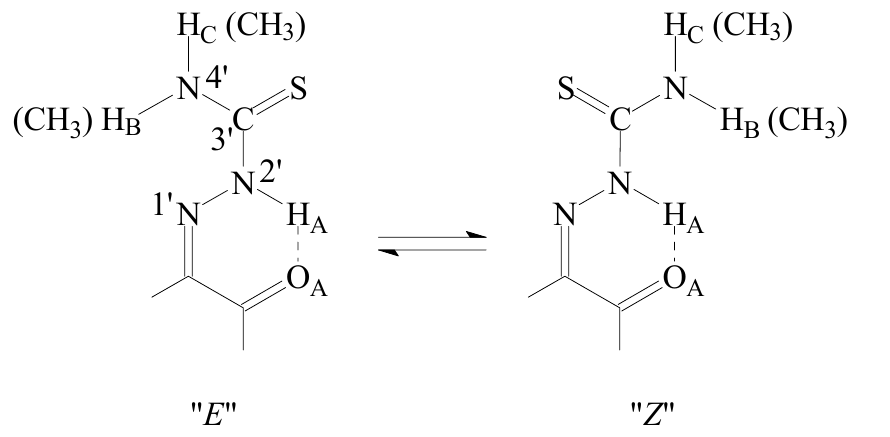
Fig. 6 The equilibrium between the two investigated isomers, the numbering scheme for the thiosemicarbazone moiety, and the definition of other significant